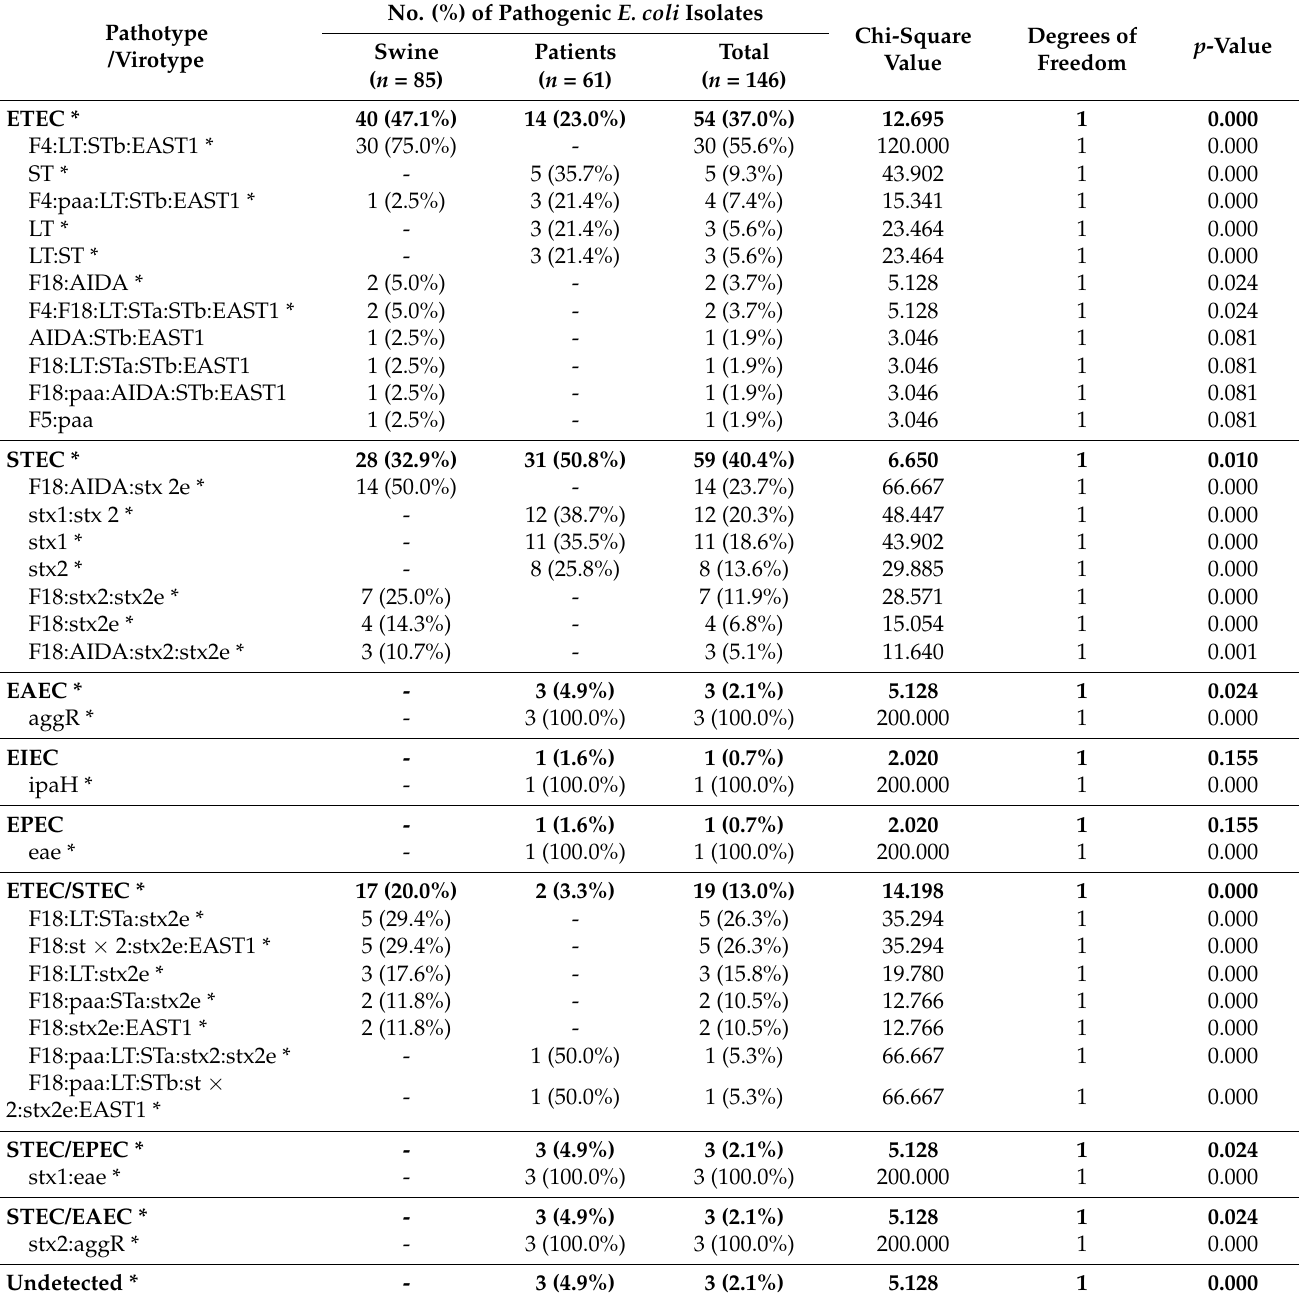
Table 1. Pathotypes and virotypes of Escherichia coli from diarrheic pigs and patients in